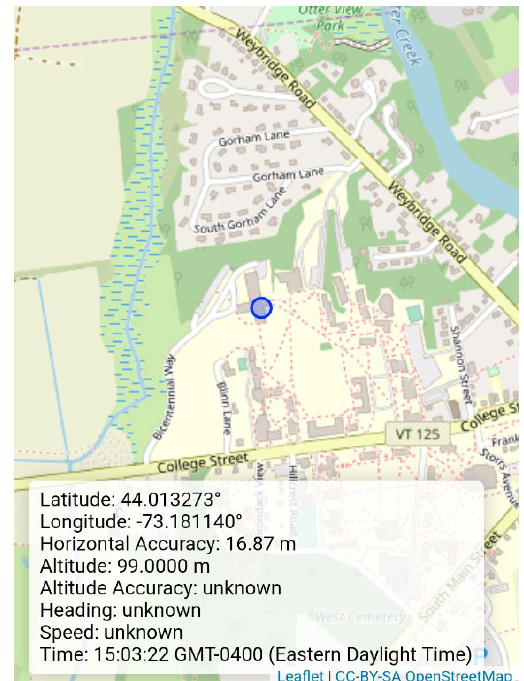
Figure 2: Leaflet map with location services for mobile devices at